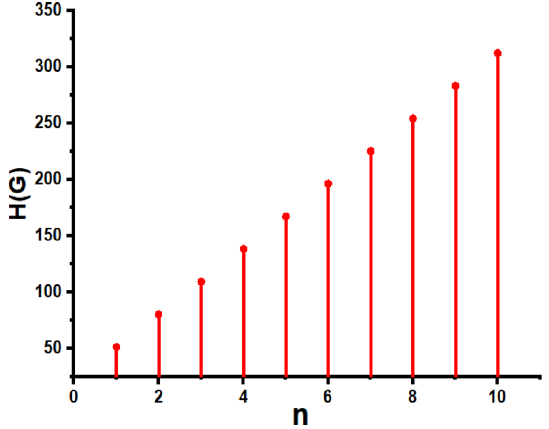
Figure 4. The comparison of n and . H ( G )